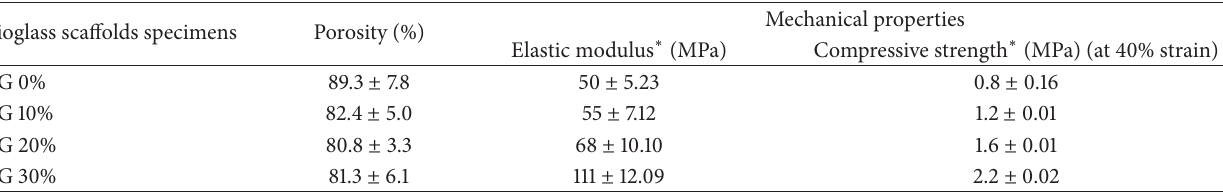
Table 5: Summery of mechanical properties of GCB scaffolds prepared from solutions of different bioglass concentrations (wt%). Data refer to mean value ± standard deviation.